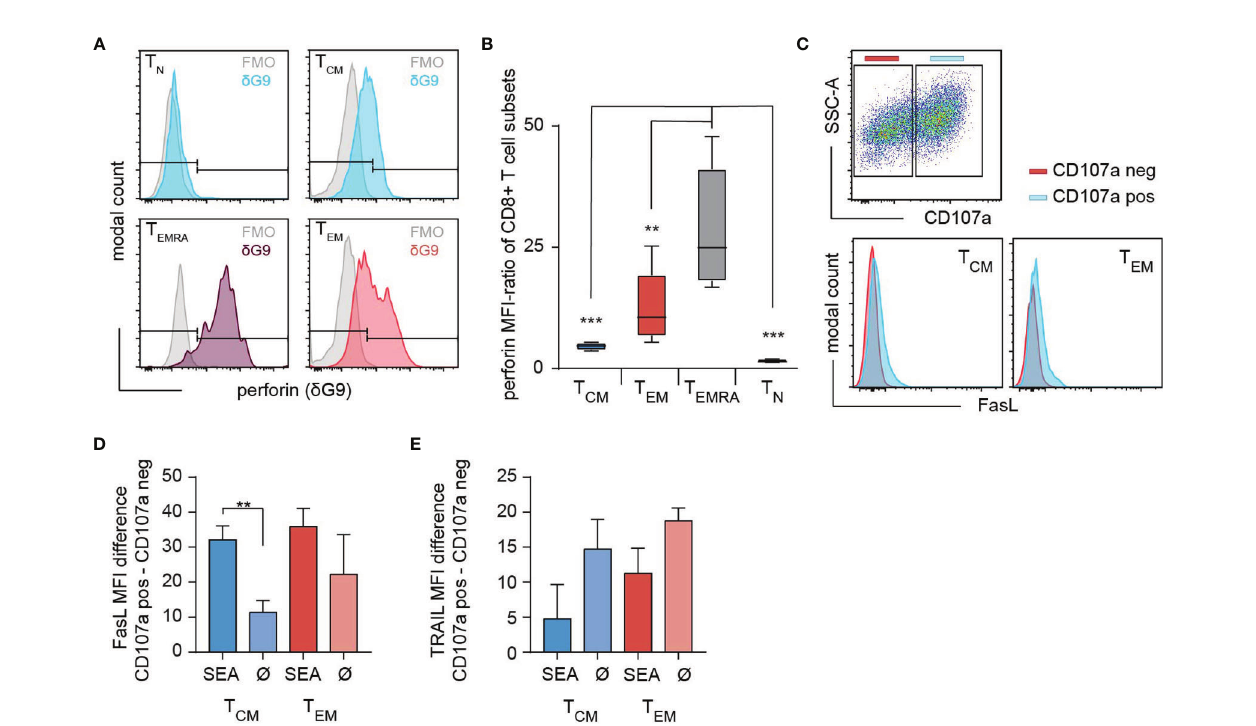
FIGURE 2 | Expression of death mediators in SEA-CTL. (A) Content of intracellular perforin stores analyzed in SEA-CTL (bead-isolated SEA-stimulated CD8 + population) subsets de fi ned by CCR7 and CD45RO (clone d G9 for perforin in lytic granules) shown for a representative donor. (B) Quanti fi cation of subset speci fi c perforin in lytic granules (clone d G9) by MFI-Ratio (MFI (perforin + population)/MFI (FMO)) shown for 5 donors. Box and Whisker plots show min, max, median, and 25-75% interquartile range. Statistical analysis was done by a two-way ANOVA. (C) CTL-SEA were co-incubated with 3x10 5 SEA-pulsed NALM6 at an E:T ratio of 2:1 for 4h in presence of CD107a antibody. Cells were collected and stained with CD45RA, CCR7, CD95L and TRAIL (CD253) antibodies. CD107a positive (CD107a pos, blue) and CD107a negative (CD107a neg, red) cells were gated for each subset (T CM and T EM ) and FasL expression was analyzed. Quanti fi cation of FasL (D) or TRAIL (E) expression on degranulating SEA-CTL (SEA) or control cells (without the addition of SEA, Ø) cells in T CM and T EM subpopulations. Data are shown as mean+SD, n=3 donors. **p<0.01;